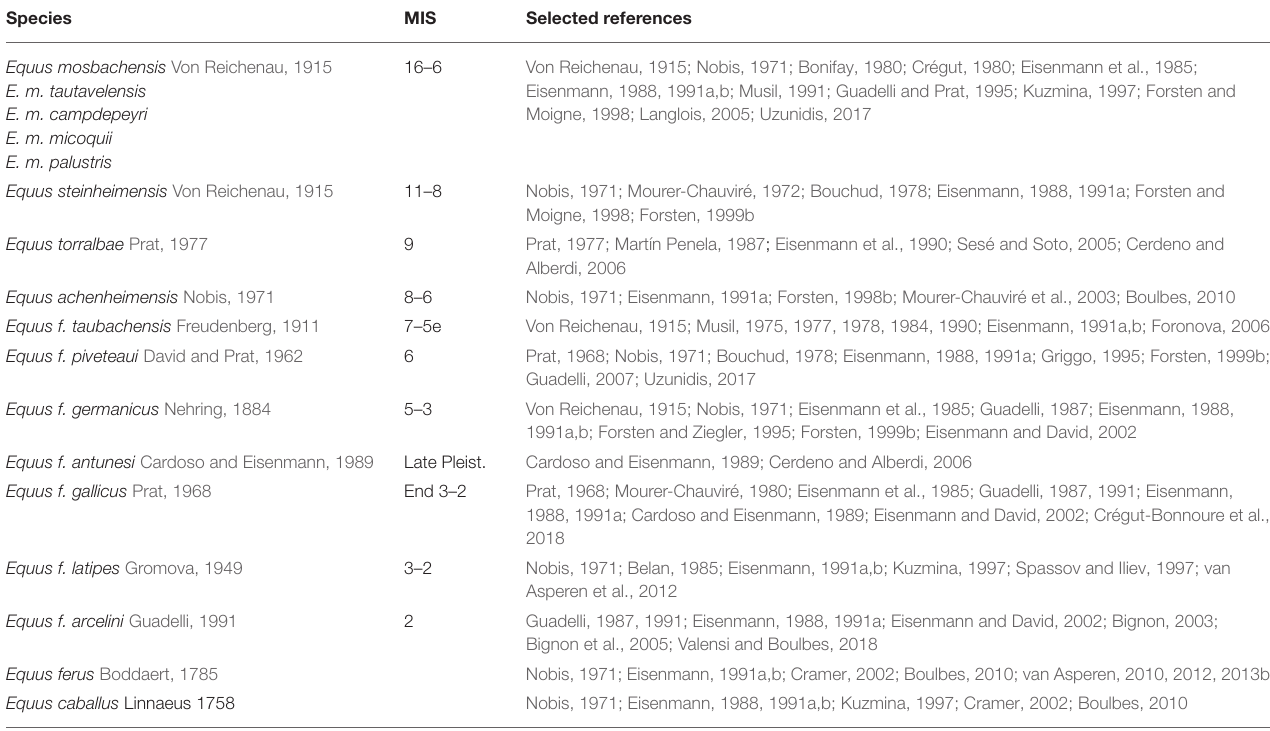
TABLE 2 | Selected species names used in the literature for Middle and Late Pleistocene European caballoid equids (NB many variants on these names also occur but are not included here).